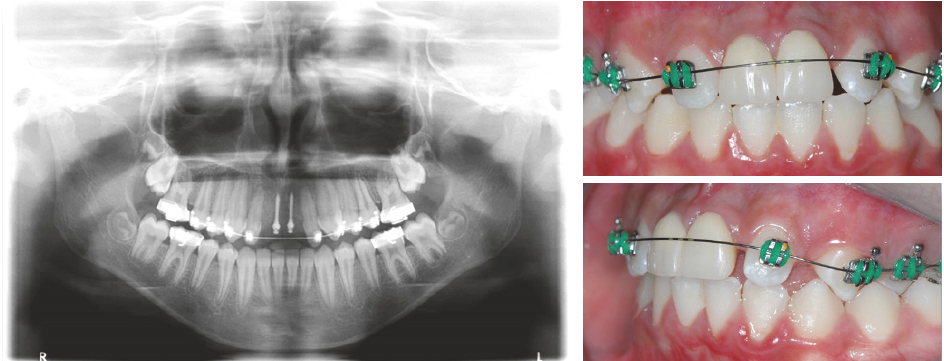
Figure 5: Clinico- and radiographic aspects one year after mini-implant